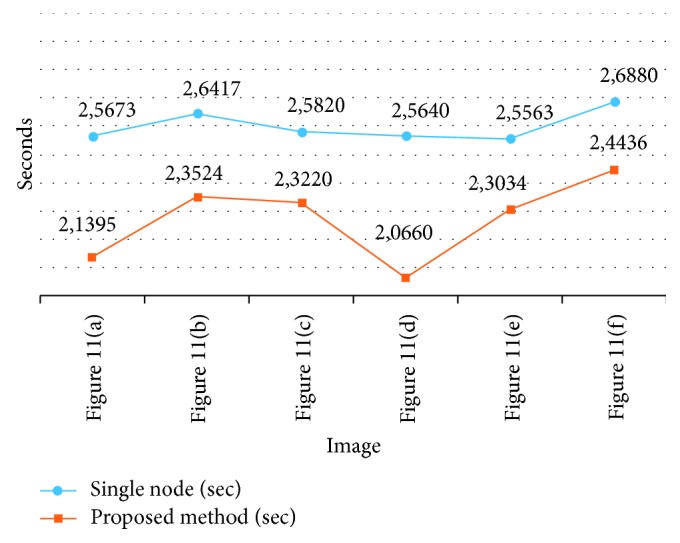
Processing speeds.